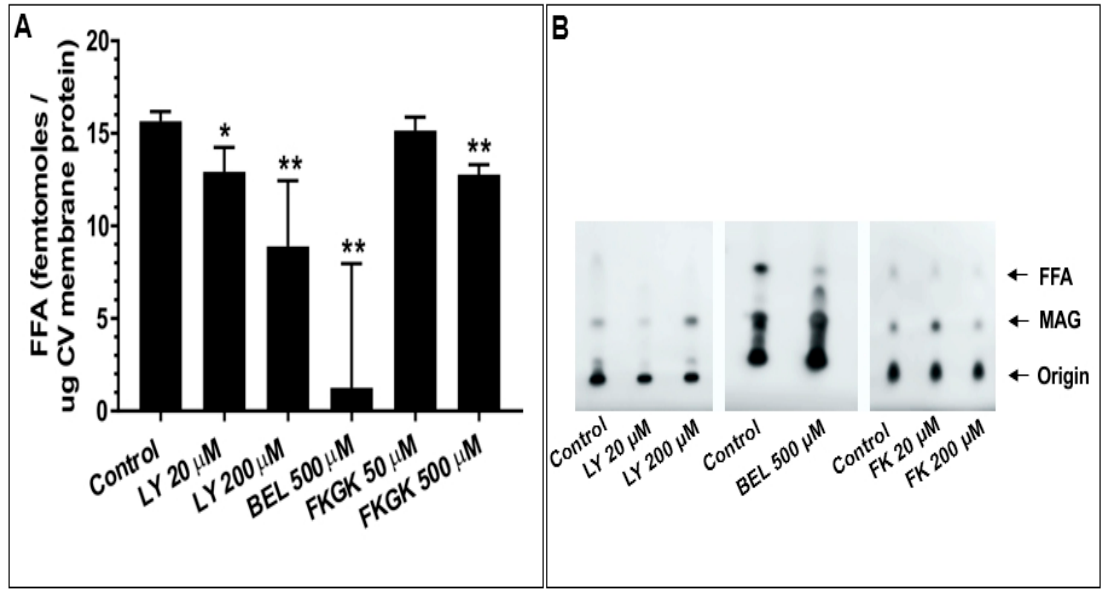
Figure 8. ( A ) Changes in the endogenous FFA in CV treated with indicated doses of LY311727, BEL and FKGK-11; n = 4–12; ( B ) Section of the chromatograms showing the changes in endogenous FFA. ( p -value, * < 0.05, ** <0.005 indicates difference relative to the control). A standard neutral lipid protocol was used to resolve the lipids [56].